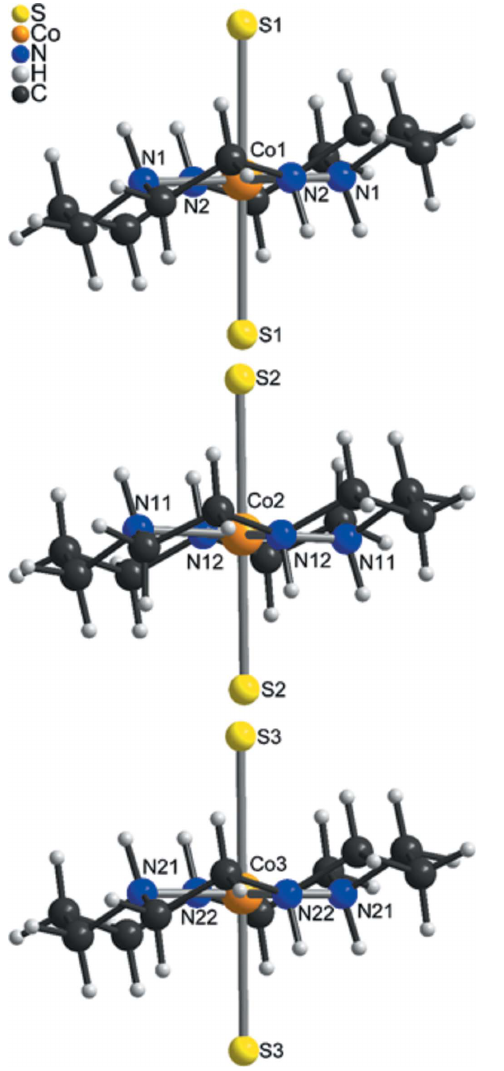
Figure 2 Crystal structure of the title compound with a view of the coordination sphere of the three crystallographically independent Co